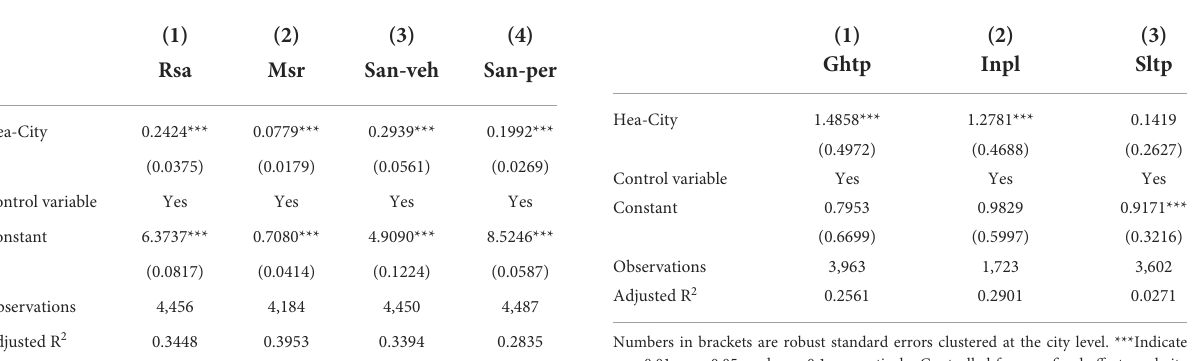
TABLE 7 Mechanism for healthy city implementation to increase the harmless treatment capacity of